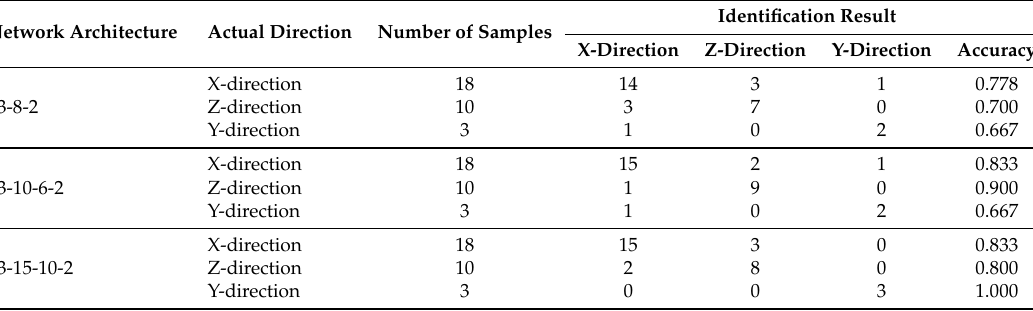
Table 7. Accuracy of direction